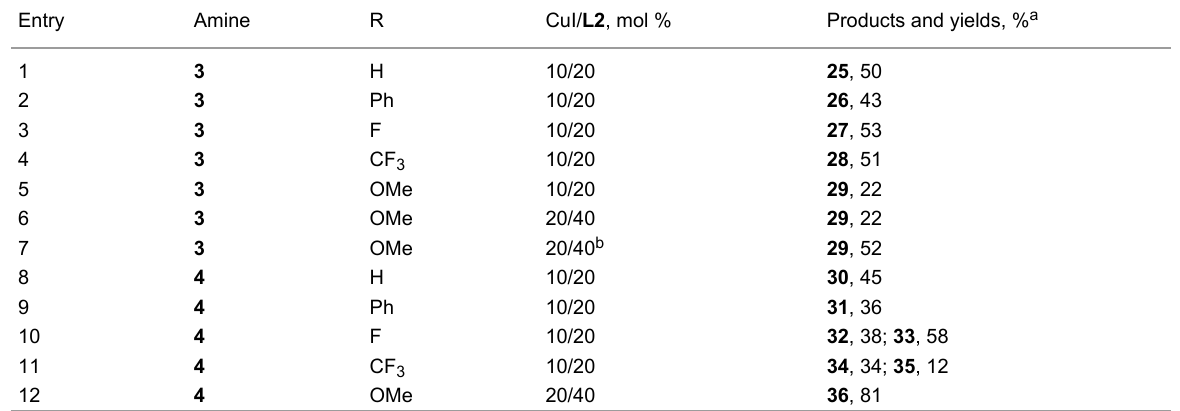
Table 3: Arylation of the diamines 3 and 4